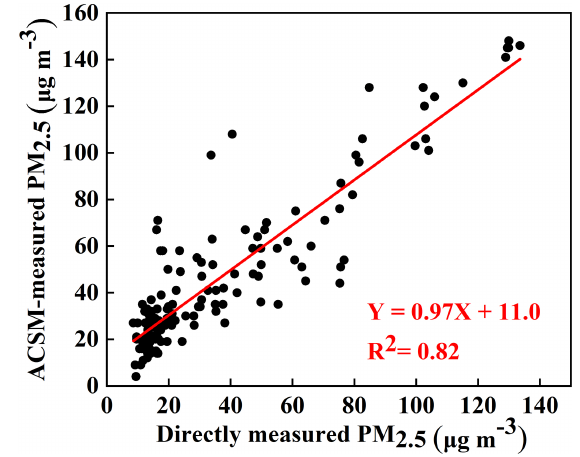
Figure 2. Scatter plot of the relationship between the directly mea- sured PM 2 . 5 mass concentration (with the particulate matter an- alyzer of the China National Environmental Monitoring Center) and the ACSM-measured PM 2 . 5 mass concentration (the sum of the chemical constituent mass concentrations measured with the aerosol chemical speciation monitor (ACSM) and the black carbon (BC) mass concentration measured with the multiangle absorption